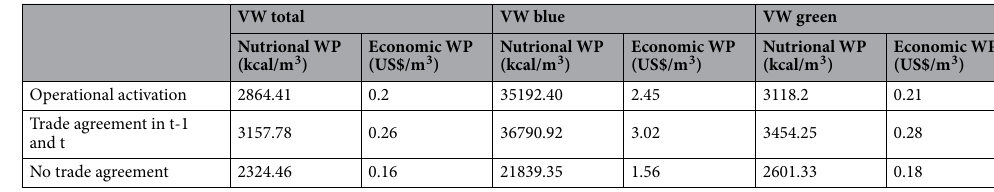
Table 3. Average of nutritional ( kcal / m 3 ) and economic ( US$ / m 3 ) water productivity (WP) for the total, blue and green virtual